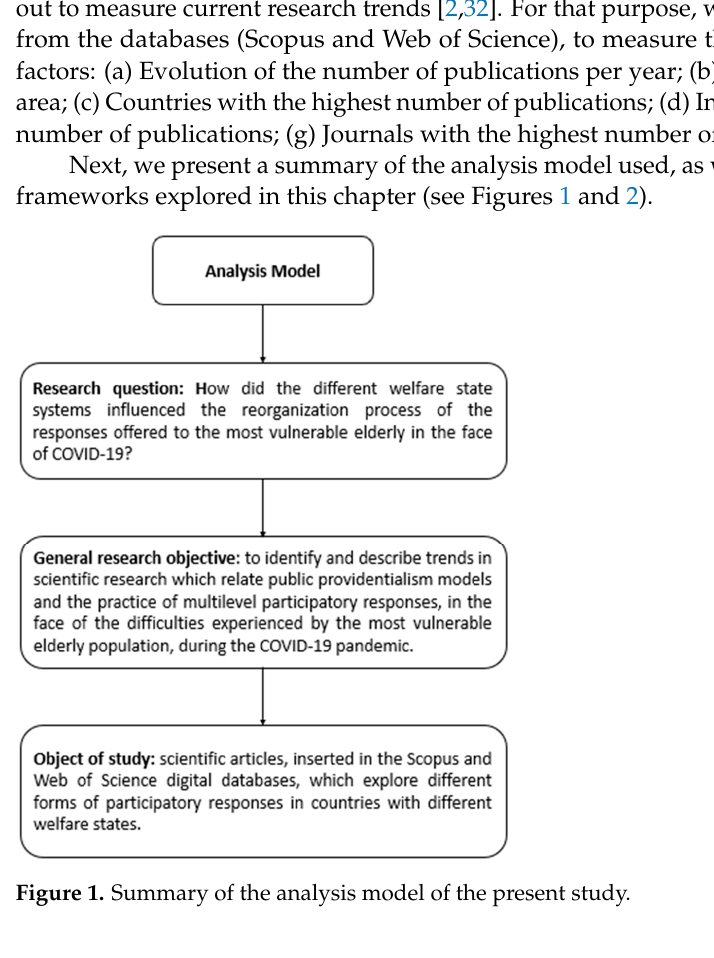
Figure 2. Summary of the methodological framework of the present study.